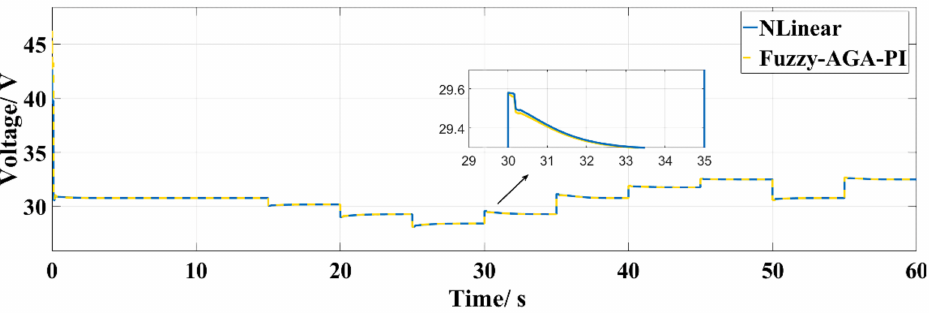
Figure 6. Voltage curve during load variation.